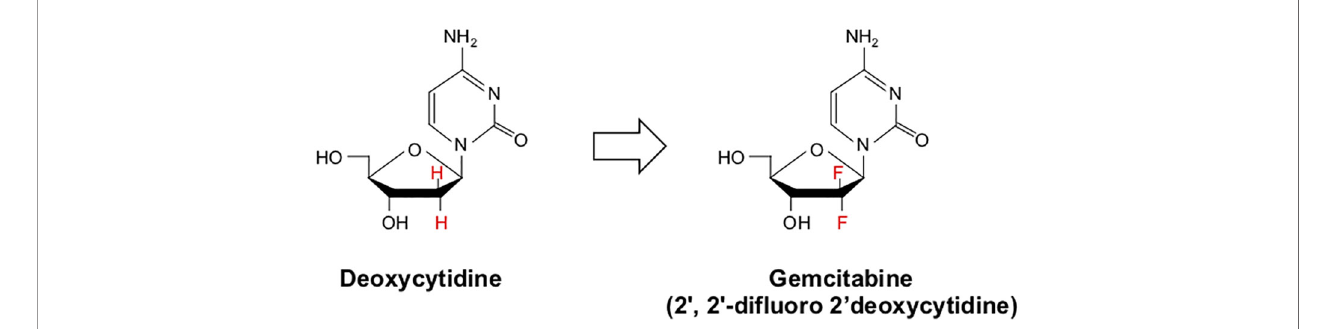
FIGURE 3 | Chemical structure of deoxycytidine and its halogenated chemical mimic Gemcitabine. Gemcitabine (2 ’ , 2 ’ -di fl uoro 2 ’ deoxycytidine or dFdC) is a nucleoside analog identical in structure to deoxycytidine apart from two fl uoride molecules at the 2